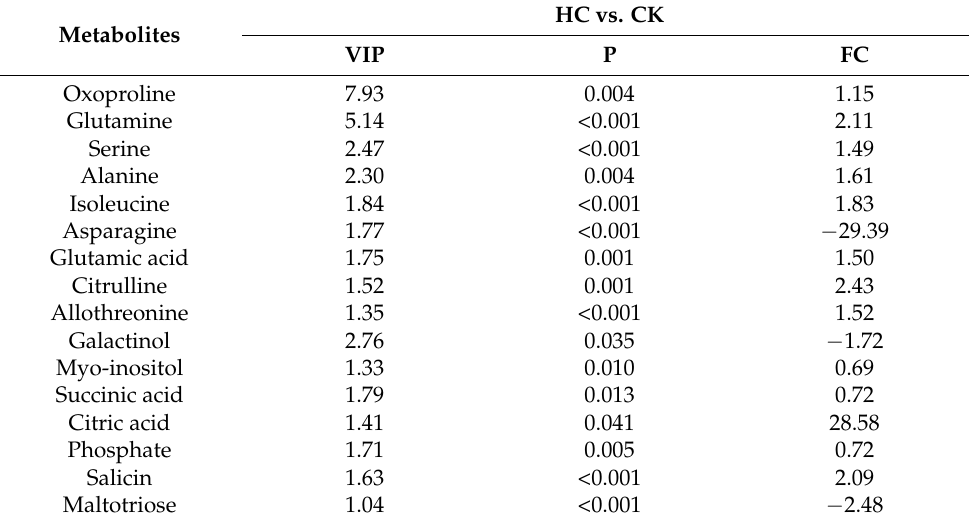
Table 1. List of the 16 metabolites with the most significant differentially quantified between the HC treatment (HC) and the control (CK). Criteria was highest VIP values and significant p -value at 0.05 (P), including the fold change